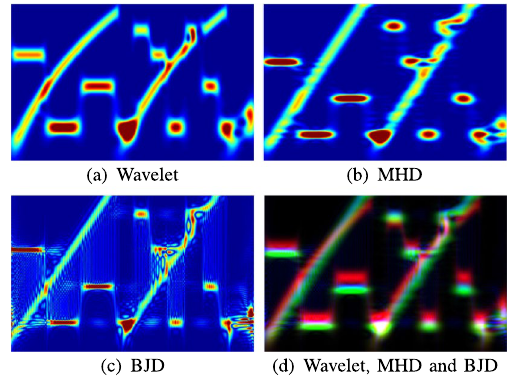
Fig. 5 Spectrogram images of interference signals with different